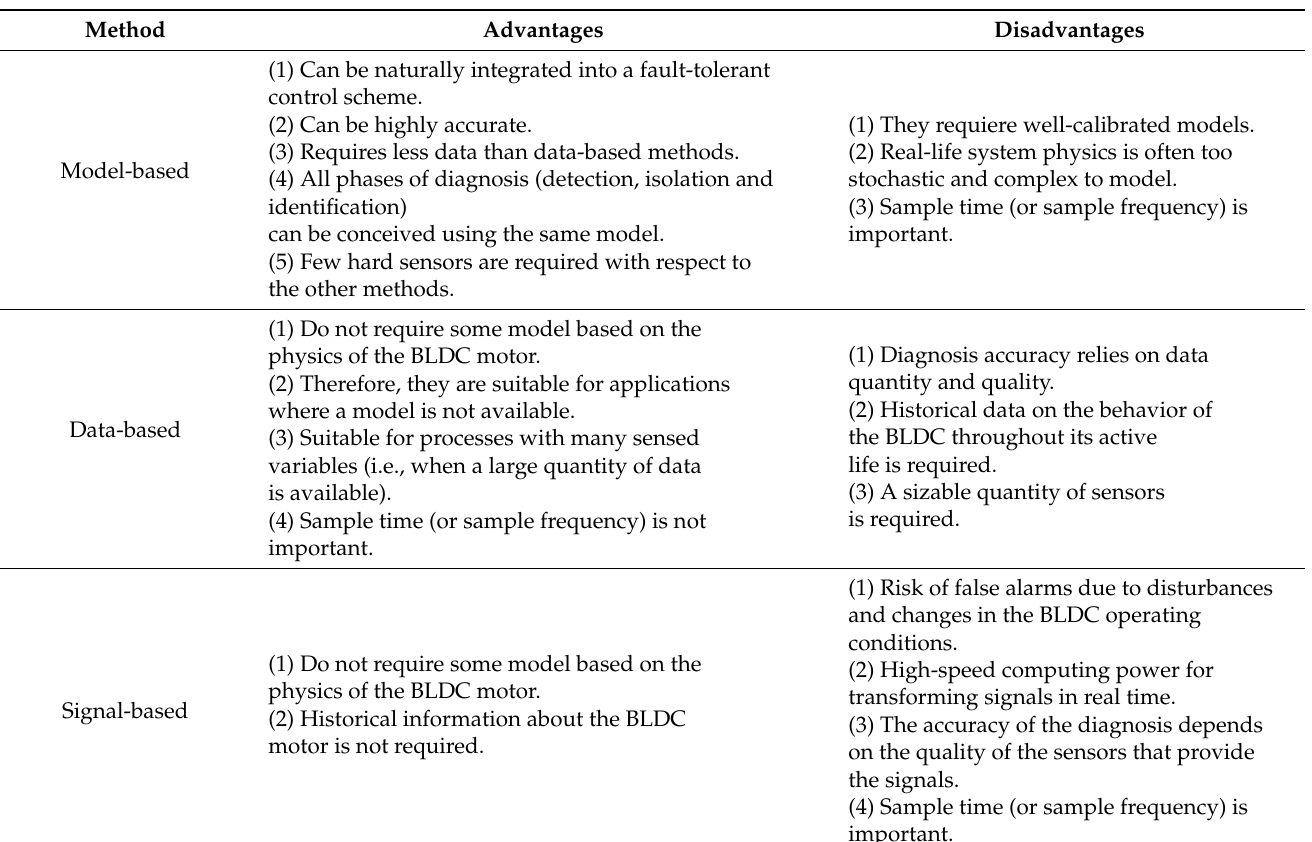
Table 5. Advantages and disadvantages of the main methods used for diagnosing stator faults in BLDC motors.